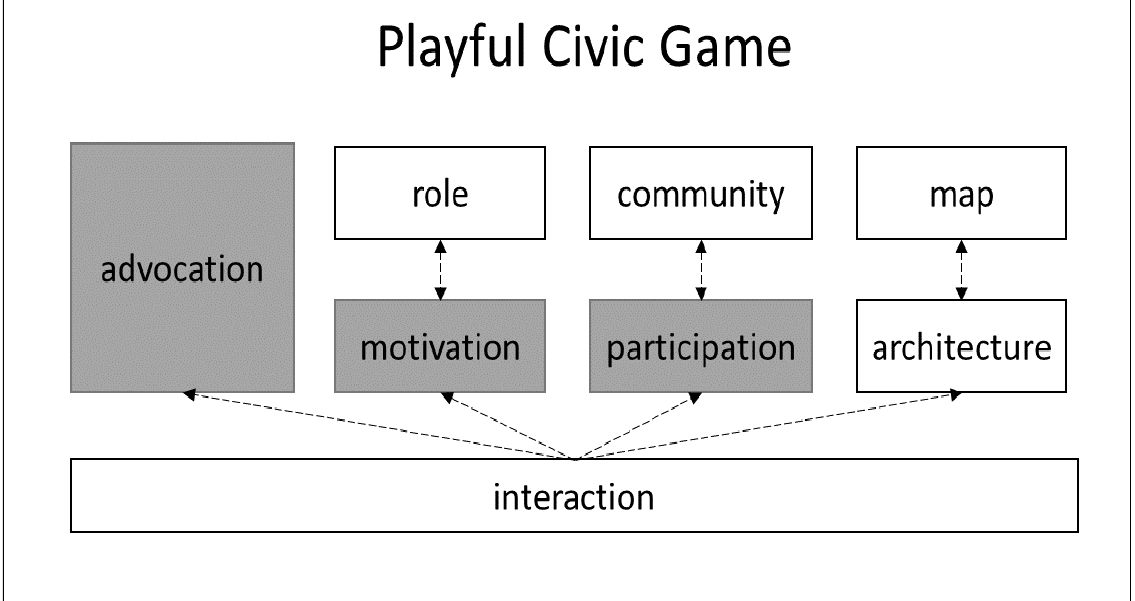
Figure 1. The framework of a playful civic